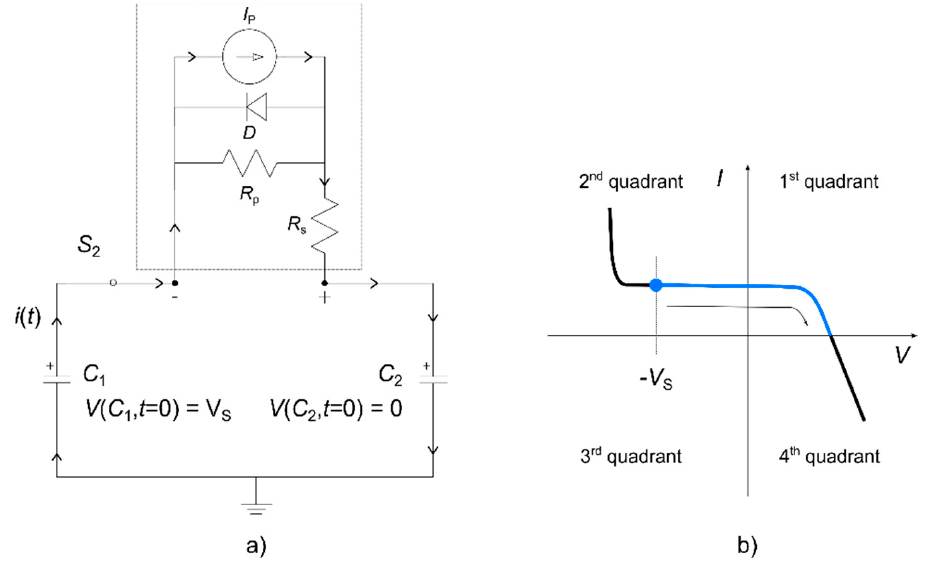
Figure 4. Step 4 of the process of measurements. ( a ) Equivalent circuit. ( b ) Path on the I-V curve.